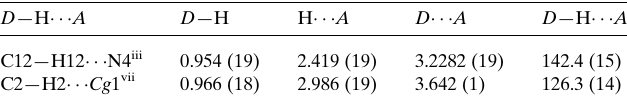
Table 1 Hydrogen-bond geometry (A˚ , (cid:2)